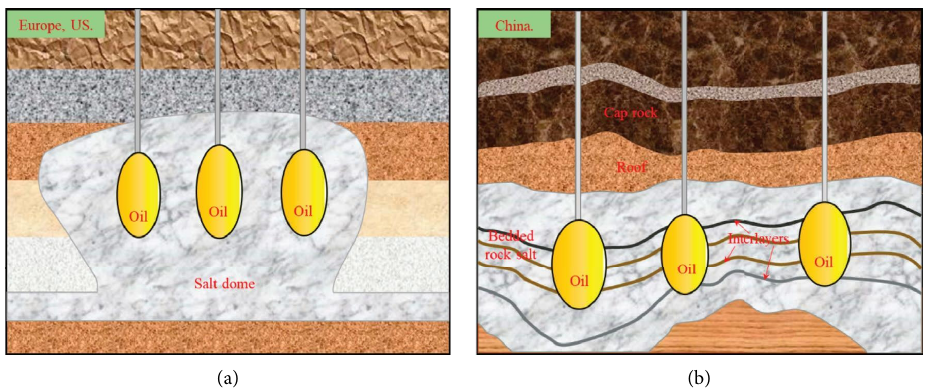
Figure 1: Salt caverns in diferent salt formations. (a) SPR caverns in salt dome. (b) SPR caverns in bedded salt